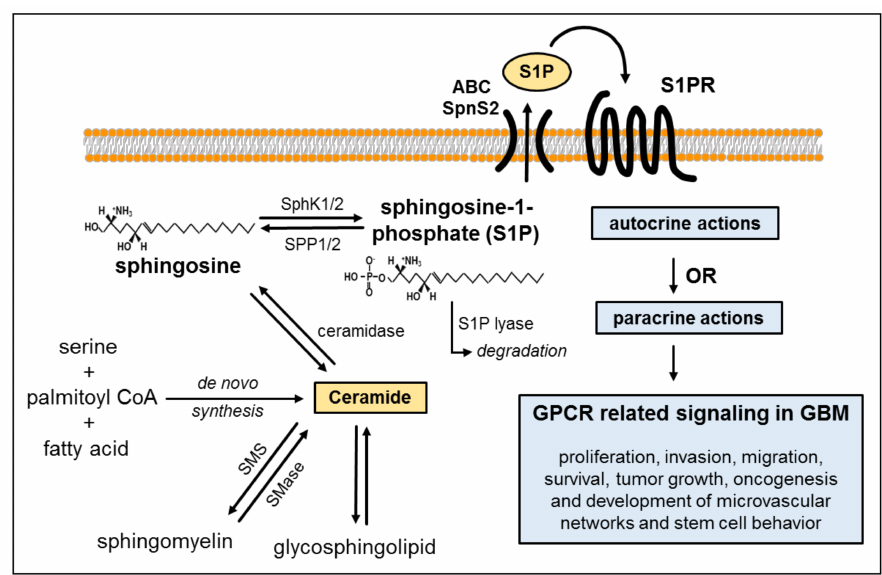
Figure 1. Biosynthesis of ceramide and sphingosine-1-phosphate (S1P) production. Ceramide de novo synthesis typically originates from the condensation of serine, palmitoyl-CoA and fatty acids—a multistep enzyme-catalyzed process. Ceramide can be transformed reversibly (indicated by the two-way arrows) into sphingomyelin by sphingomyelinase or to glycosphingolipids. It is further metabolized to sphingosine by ceramidase. Sphingosine can then be phosphorylated into S1P by the sphingosine kinase isoforms 1 and 2 (SphK1/2). This phosphorylation can be reverted by the S1P phosphatases 1 and 2 (SPP1/2), or irreversible degradation by S1P lyase can occur. S1P produced intracellularly is exported out of the cell via ATP-binding cassette transporters (ABC) transporters or spinster homolog 2 (Spns2), dependent on the cell type. Subsequently, it can act either in an autocrine or paracrine manner by binding to one of its receptors (S1PR1–5) to regulate multifaceted cellular functions via G-protein-mediated signaling. S1P promotes key processes of glioblastoma multiforme (GBM) pathogenesis which involve cell proliferation, invasion, migration, survival, tumor growth,